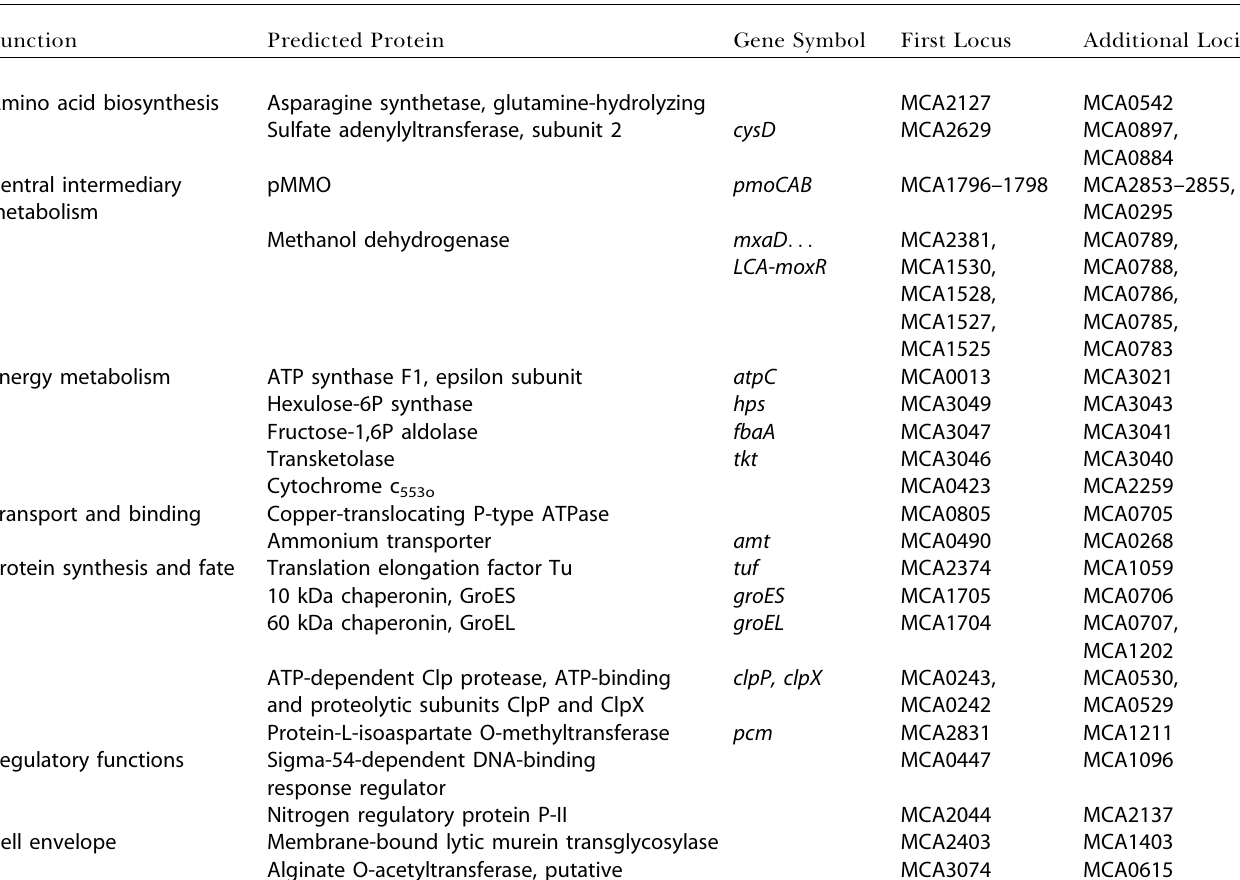
Table 2. Selected Putative Lineage-Specific Gene Duplications in M. capsulatus (Bath)